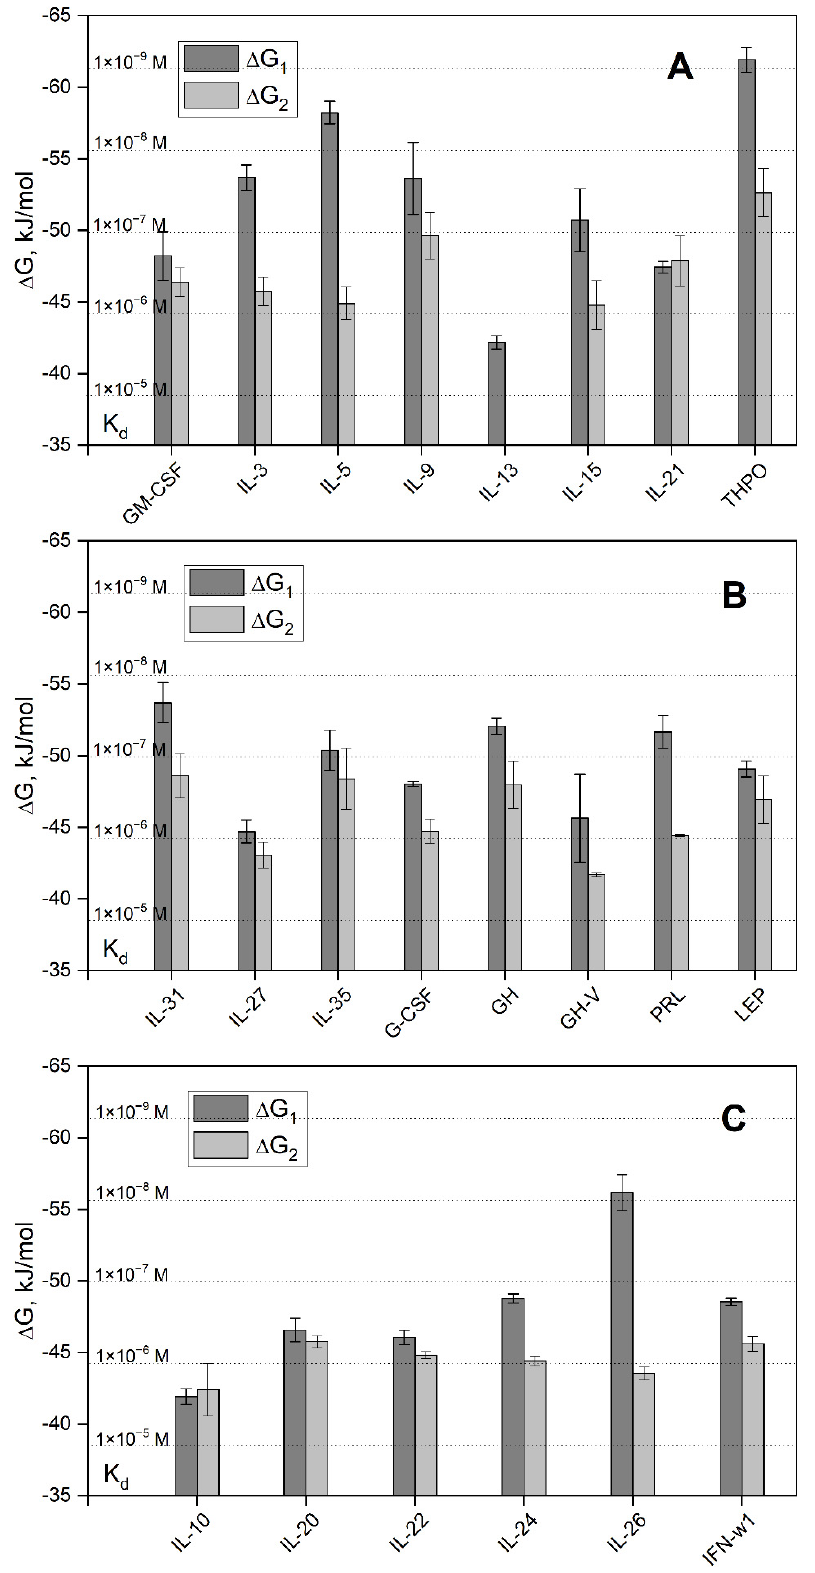
Figure 4. The free energy changes, accompanying the interaction between Ca 2+ -loaded S100P and the four-helical cytokines of short-chain (panel A ), long-chain ( B ) or interferons/IL-10 ( C ) families at 25 °C, calculated from the SPR data shown in Table 3: Δ G i = − RT ln(55.3/ K di ), i=1,2. The scale of K d values is indicated.